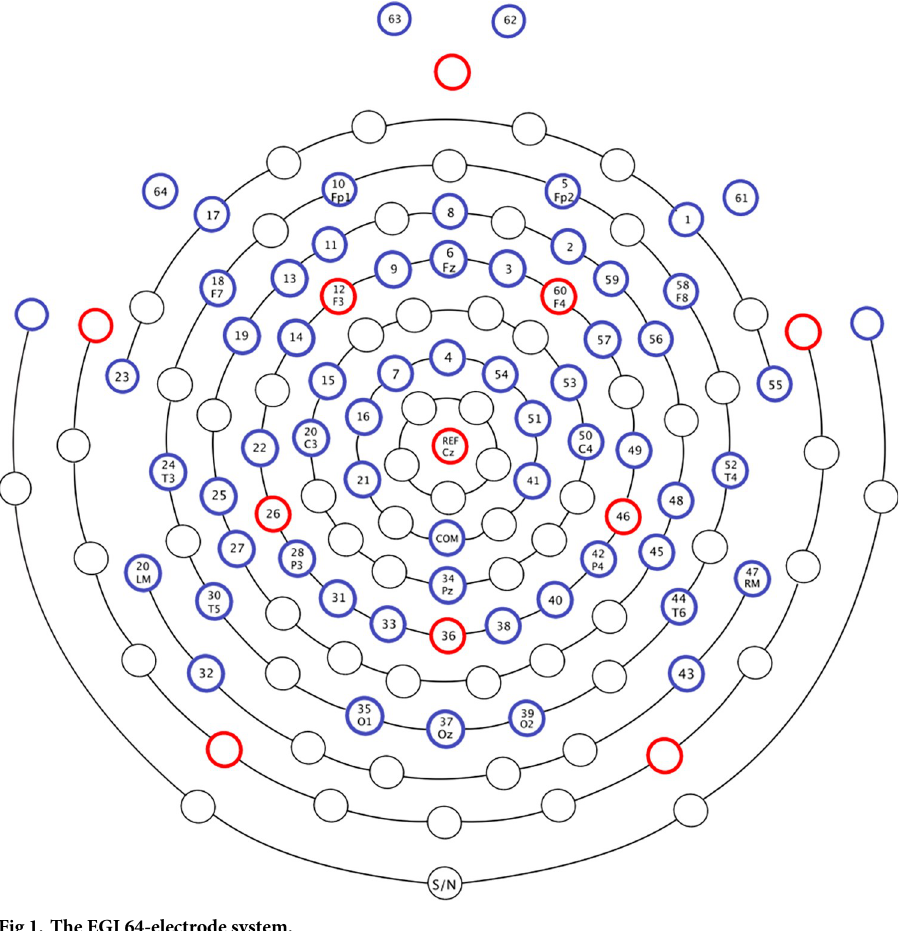
Fig 1. The EGI 64-electrode